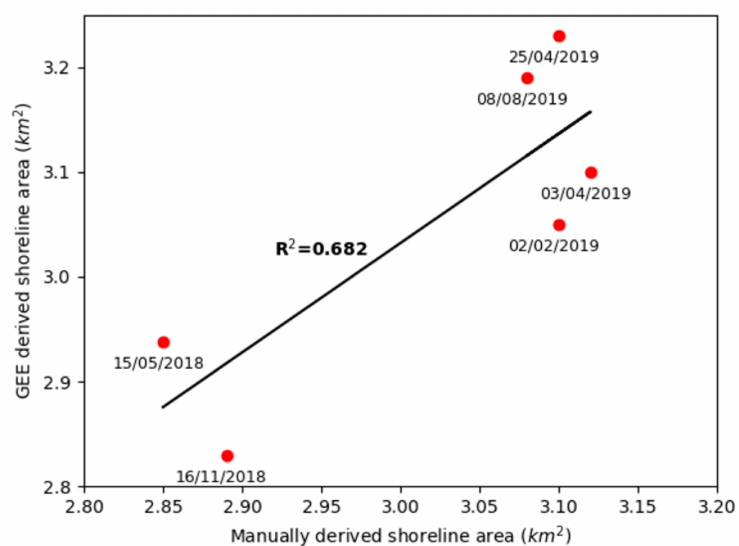
Figure 7. Correlation between the area of the Anak Krakatau Island obtained from Google Earth Engine procedure and manual interpretation of the Sentinel-2 imagery for four di ff erent dates. The linear regression fit is represented by a black solid